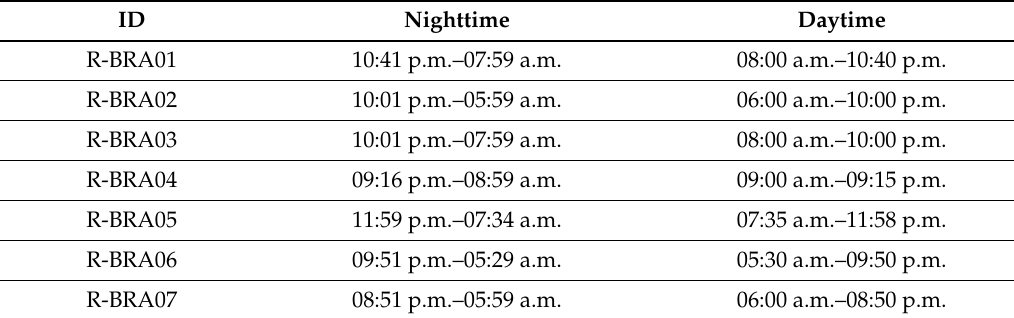
Figure 6. Ascent and descent glucose rate from individual R-BRA07 during 14 days along nighttime (from midnight to eight am) considering time intervals of 30 min. Table 6. Volunteers’ nighttime and daytime